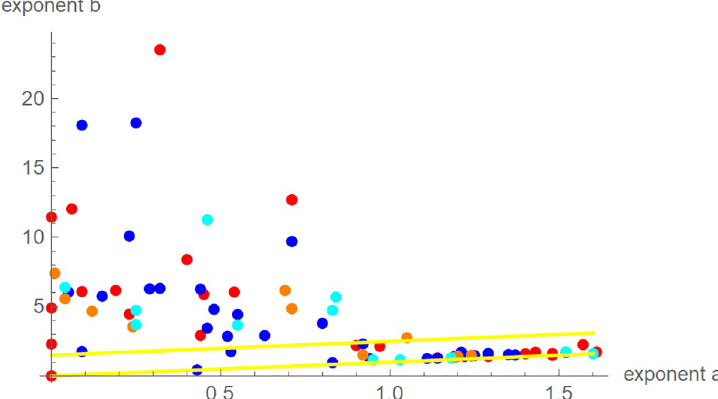
Fig 3. Best-fit exponent-pairs for 81 nestlings of female blue tits (red), male blue tits (blue), female great tits (orange), male great tits (cyan), and yellow lines (b = a and b = a+1.5) to indicate near-diagonal exponent-pairs.